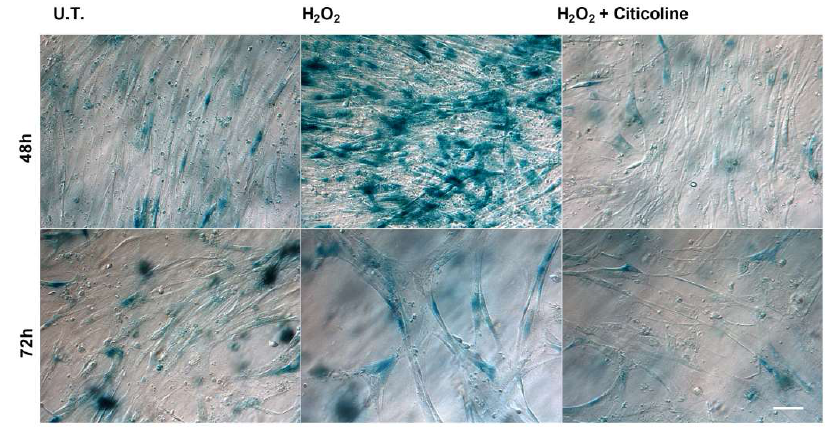
Figure 5. Senescence-associated β-galactosidase staining. HTMCs were stained for senescence-associated β-galactosidase after treatment with H 2 O 2 alone or in combination with citicoline (scale bar marker corresponds to 40 µm). UT = untreated HTMCs.